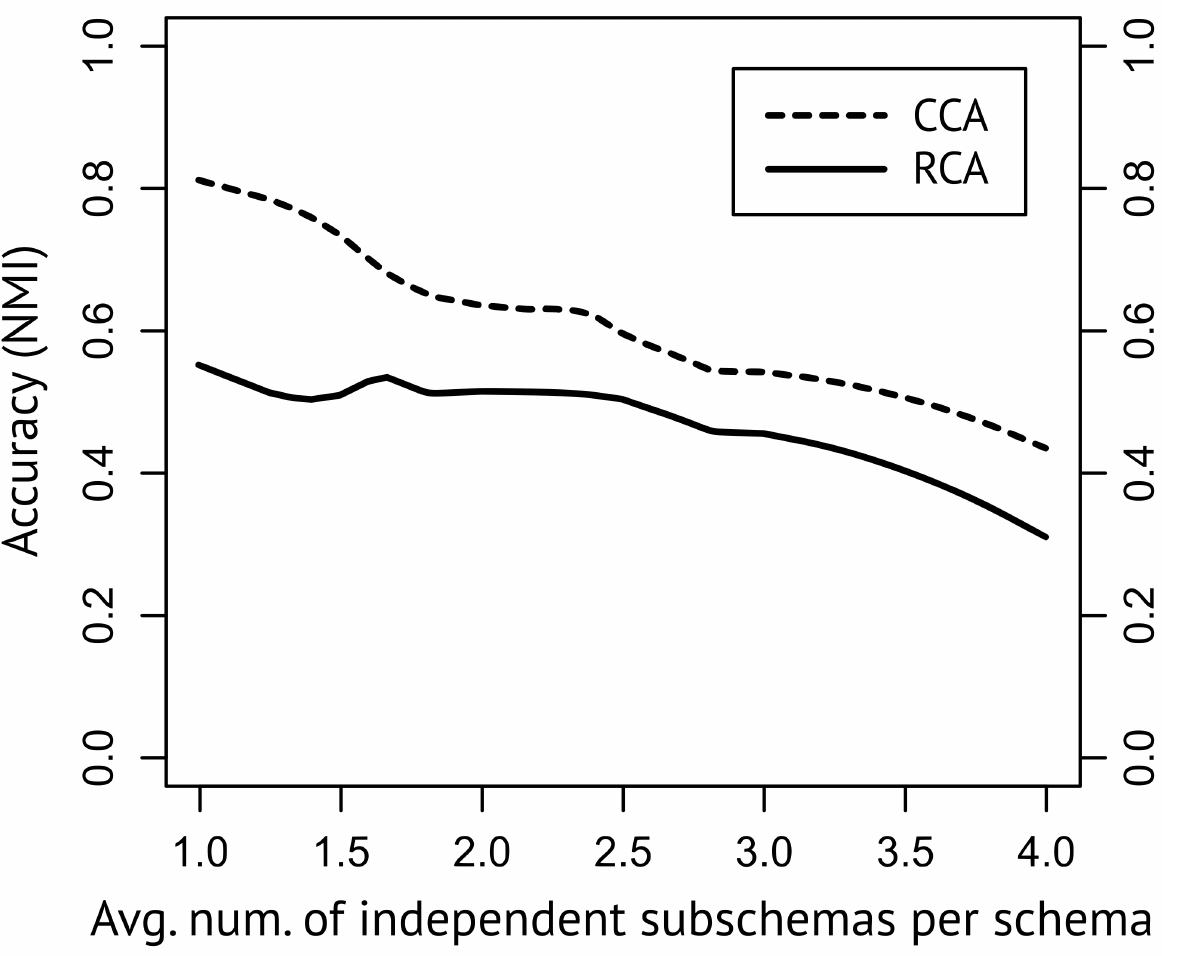
Figure 8: Accuracy for 2,000 simulations with independent